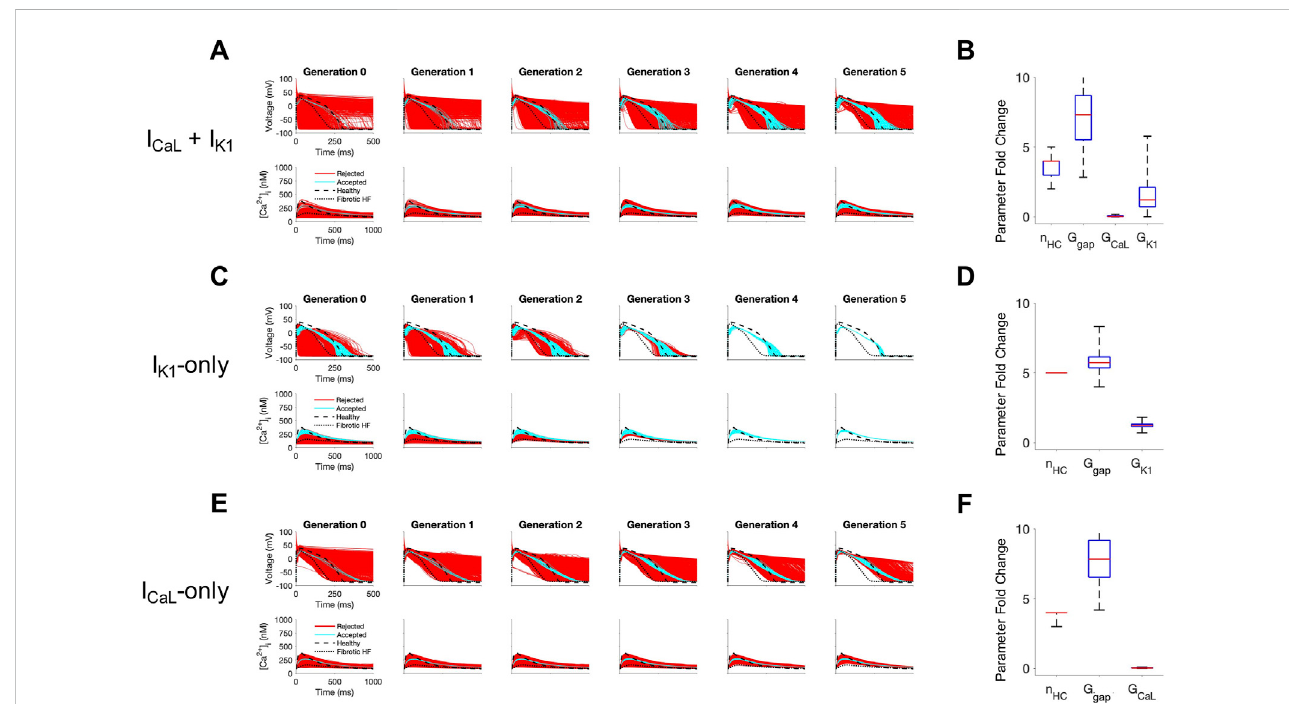
FIGURE 4 Custom cells expressing cardiomyocyte L-type calcium and inward recti fi er channels are capable of correcting fi brotic failing cardiomyocytes. Initial populations of 2500 custom cell models were generated expressing (A) L-type calcium (I CaL ) and inward recti fi er (I K1 ) channels; (C) I K1 only; and (E) I CaL only with pseudo-random perturbations to gap junction conductances, number of heterocellularly coupled custom cells to fi brotic heart failure (HF) cardiomyocytes,andcustomcellionchannelmaximalconductances.Customcellpopulationsunderwent5generationsofgeneticalgorithmevolution, whereby custom cells were accepted if root mean square error was less than 50% for both action potential and calcium transient waveforms (blue); models outside this range were rejected (red). Distributions of accepted custom cell model parameter fold changes (relative to baseline values) in the fi brotic HF condition are shown as box and whisker plots for (B) I CaL and I K1 , (D) I K1 , and (F) I CaL . Note for certain parameters, a fold-change > 10 is achieved due to the genetic algorithm mutation step. Waveforms for healthy and untreated HF cardiomyocytes are indicated by dashed and dotted lines,